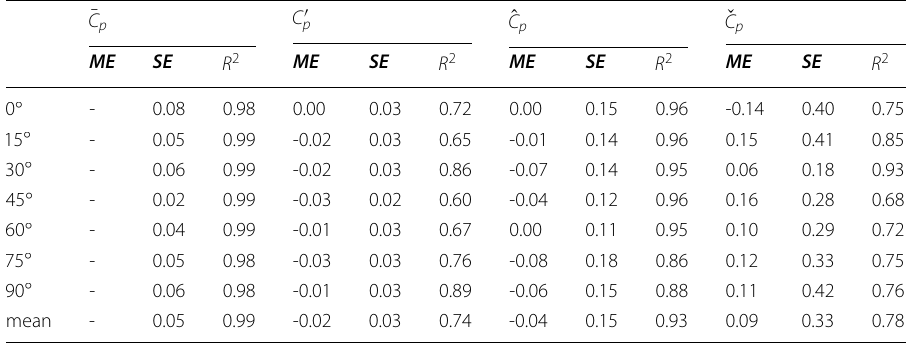
, ˆ C p and ˇ C p for wind attack angles from 0 ◦ to 90 ◦ p